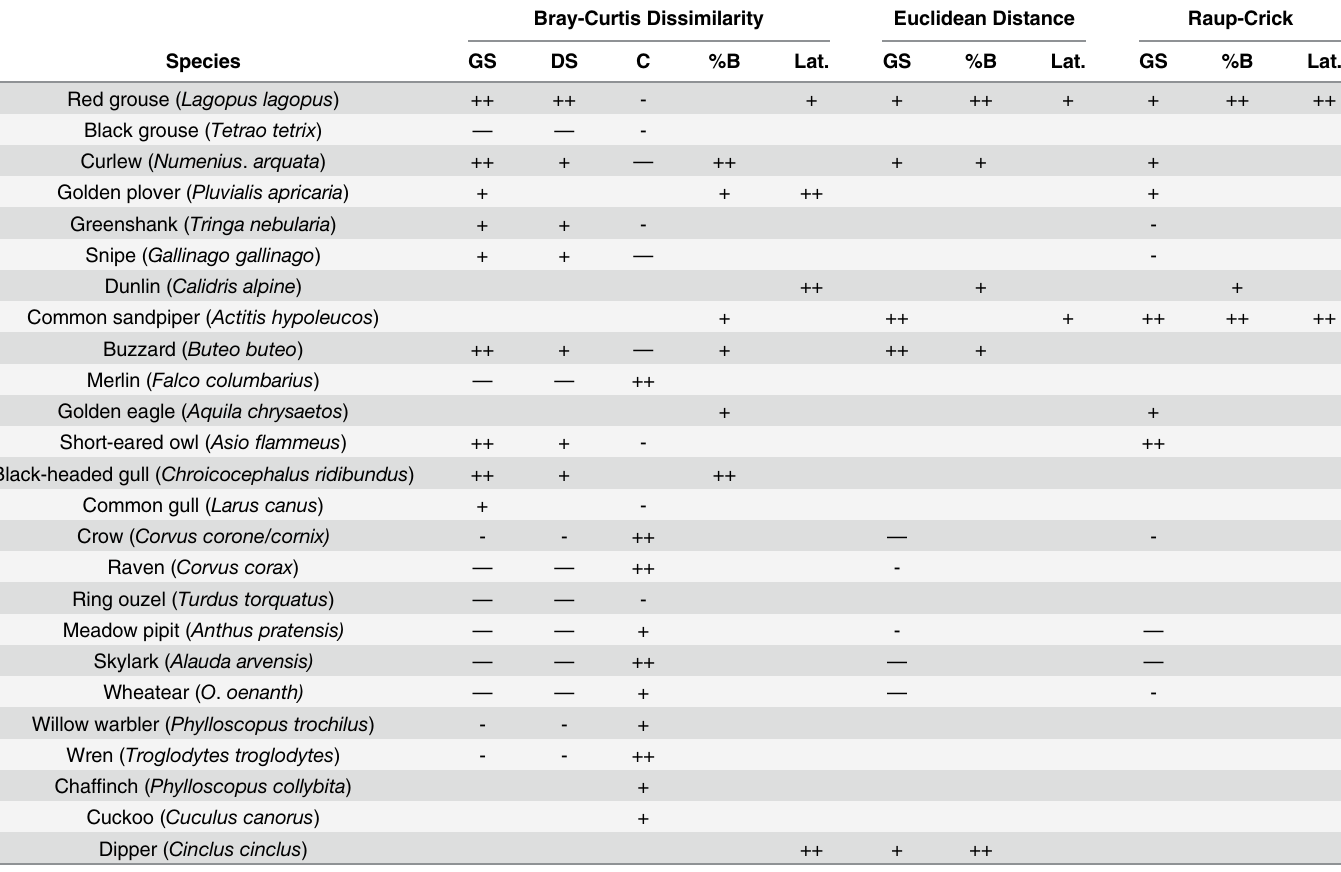
Table 5. Community composition in relation to management objectives and practices. Significant positive and negative associations are shown for each species for the management objectives, practise and variables that were identified as significant in the ordination analyses.